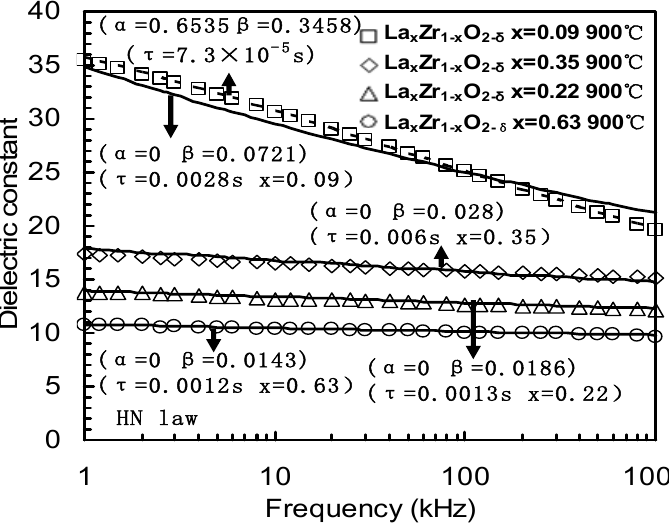
Figure 16. Frequency dependence of the k -value was extracted from C- f measurements observed in four La Zr O thin films. The square-symbols were measured from the x 1 − x 2 −δ La Zr O sample. The diamond-symbols were measured from the La Zr O 0.09 0.91 2 −δ 0.35 0.65 2 −δ sample. The triangle-symbols were measured from the La Zr O sample. The 0.22 0.78 2 −δ circle-symbols were measured from the La Zr O sample. Solid lines are from fitting 0.63 0.27 2 −δ results from the Cole-Davidson equation, while the dashed line is from the HN